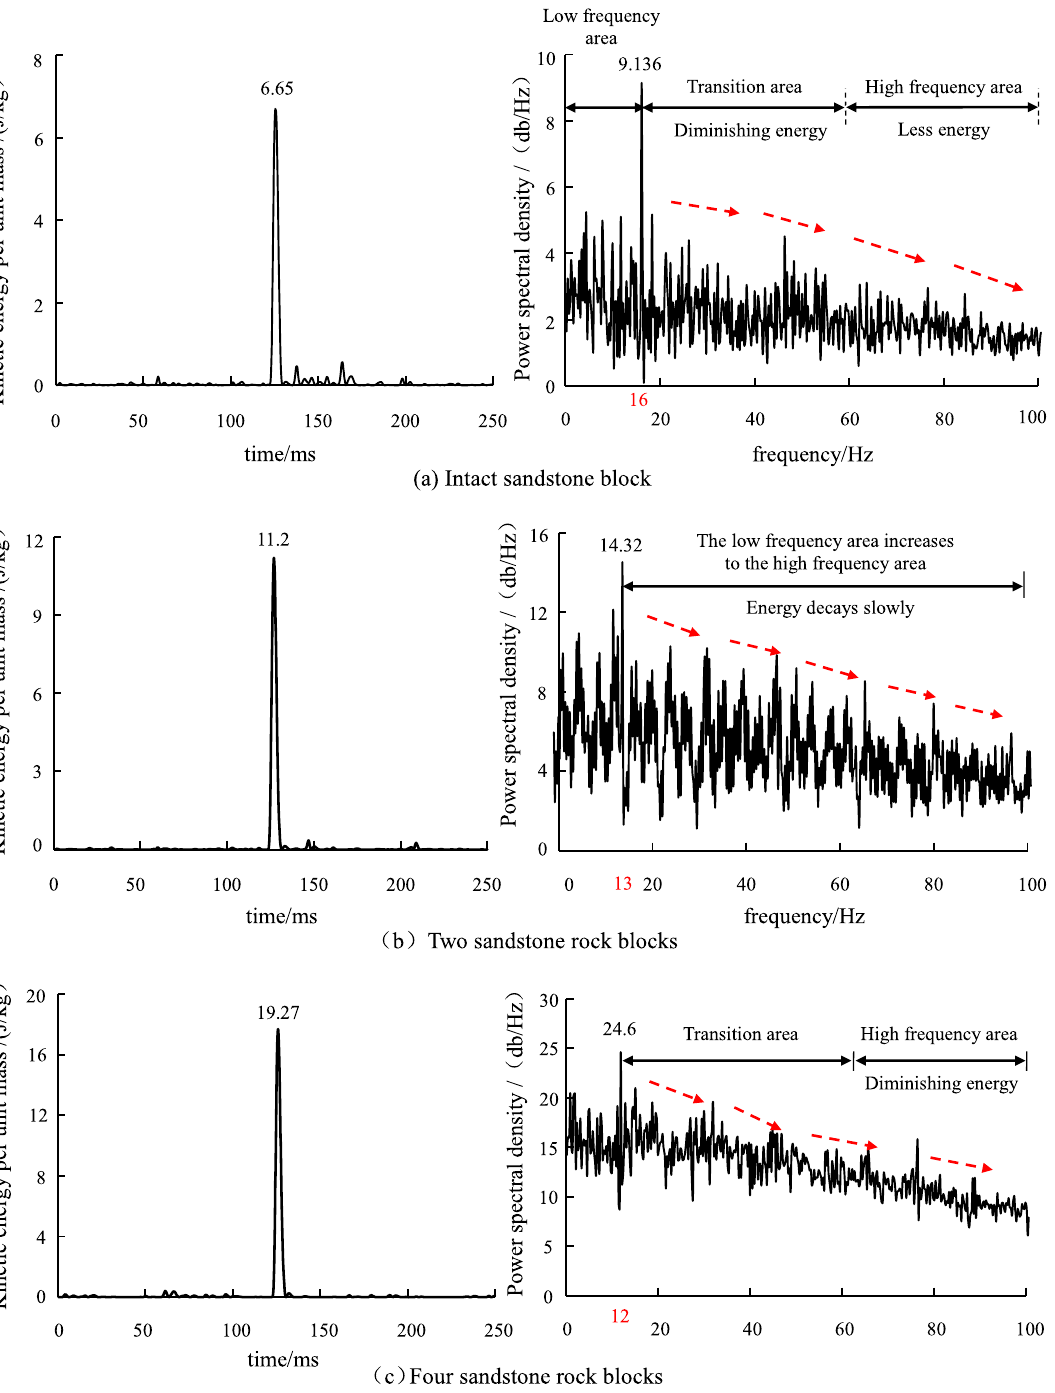
Fig. 11 Kinetic energy per unit mass and curves of power spectral density of different degrees of fracture under a horizontal impact of 1.5